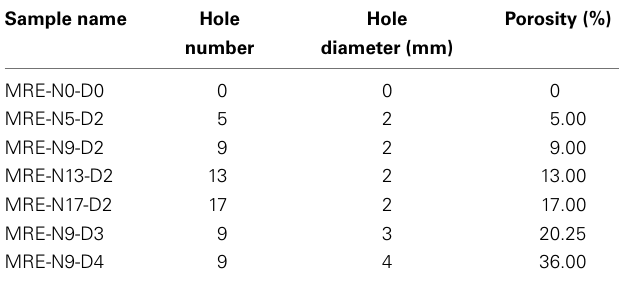
FIGURE 1 |The flow chart of samples preparation .